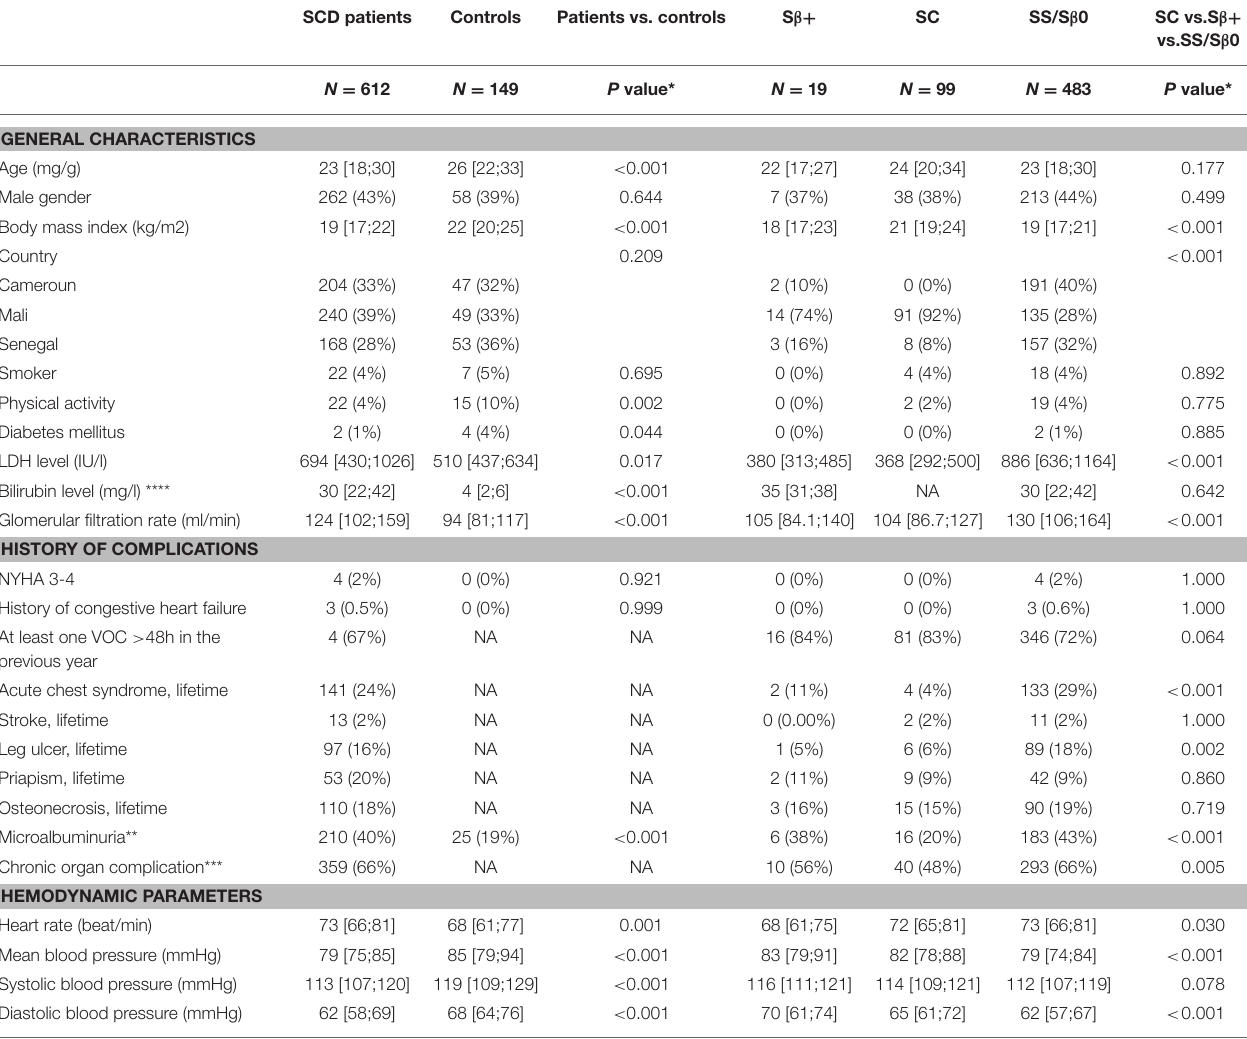
TABLE 1 | Demographic and clinical data of patients with sickle cell disease and controls. SCD patients Controls Patients vs.